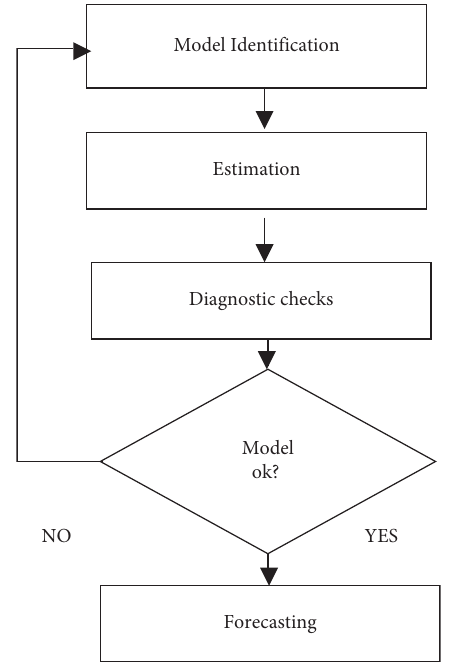
Figure 1: Summary of the Box–Jenkins